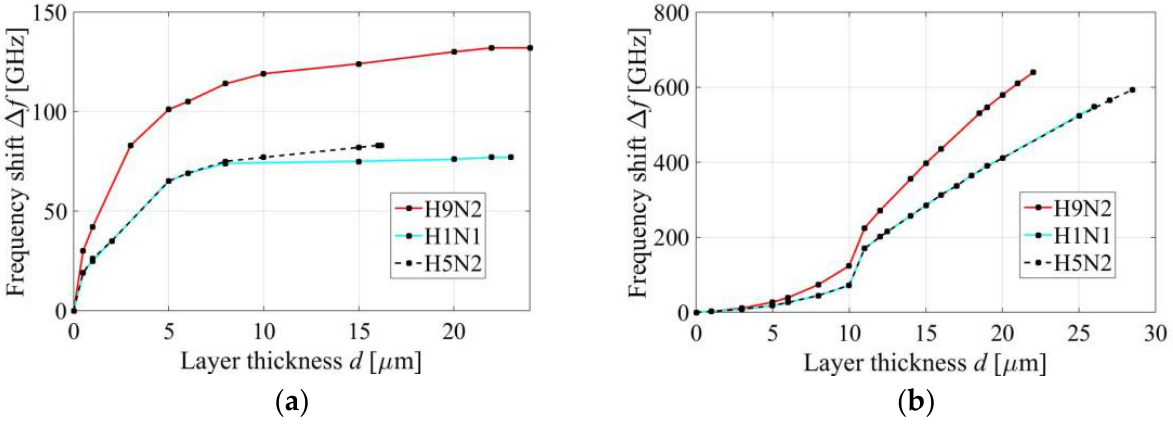
Figure 12. Detection curves around the second peak for ( a ) SquarePMA and ( b ) CrossPMA. Table 5. Numerical representation of sensitivity parameters around the second peak for SquarePMA.